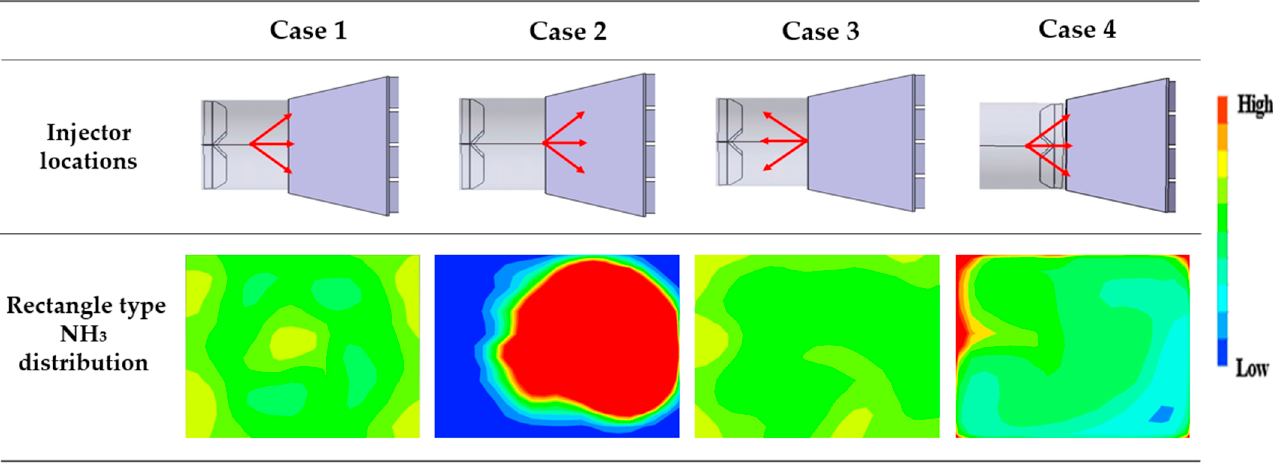
Figure 7. NH 3 distribution with injector locations.